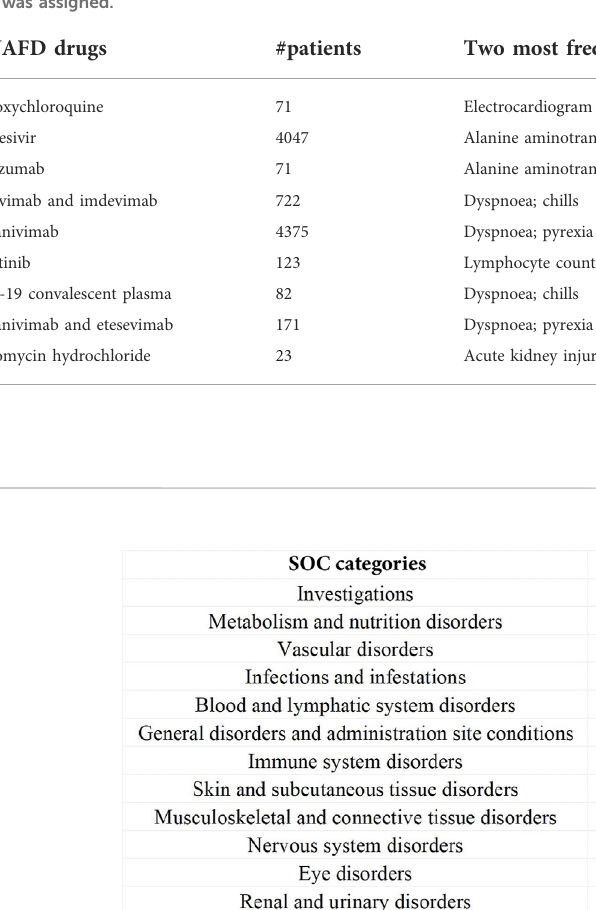
TABLE 1 Summary of nine CEUAFD drugs. Information on nine widely used CEUAFD drugs (more than 20 items of AE feedback in the CEUAFD by September 2021) is shown, including the number of patients taking one speci fi c drug, the two most frequent AEs, and the cluster to which each drug was assigned.